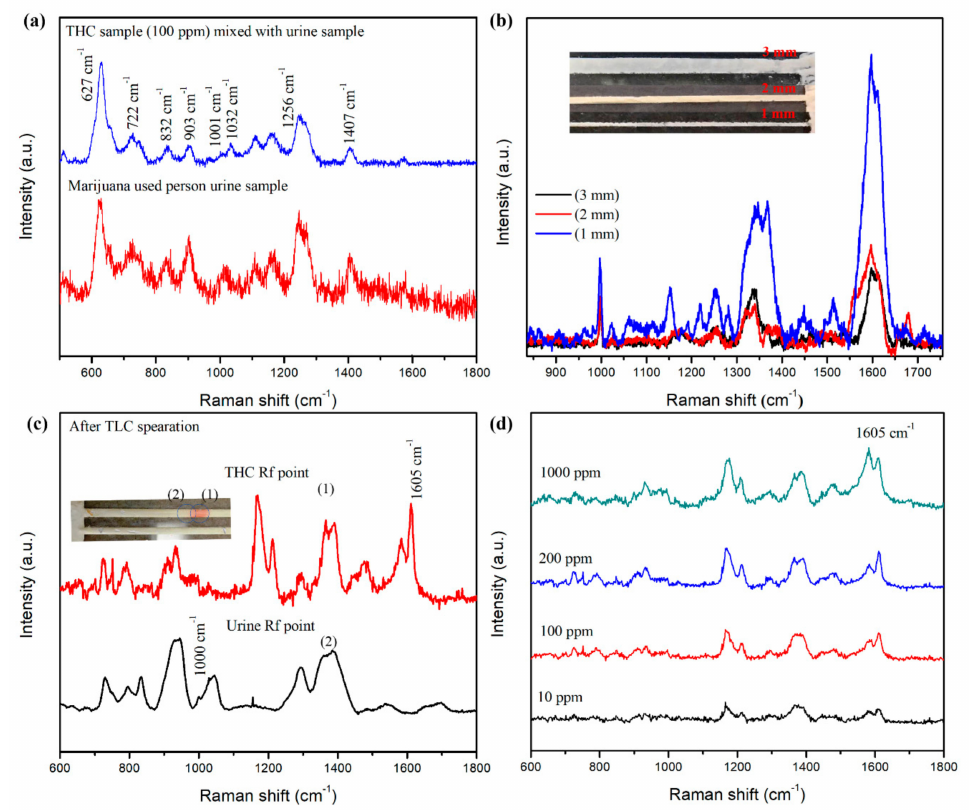
Figure 4. ( a ) SERS spectra of THC-spiked (100 ppm) urine, and marijuana-user’s urine samples measured from the diatomaceous SERS substrates. ( b ) TLC-SERS spectra of THC (500 ppm) from diatomaceous earth TLC plates with 1, 2, and 3-mm channel widths (inset figure shows TLC channels). ( c ) TLC-SERS spectra of THC and urea from THC-spiked urine sample, and ( d ) TLC-SERS spectra of THC from various concentrations of THC-spiked urine